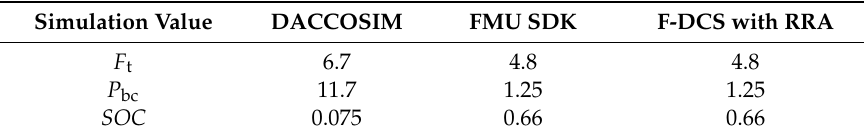
Table 2. MAPE (%) of simulation values.